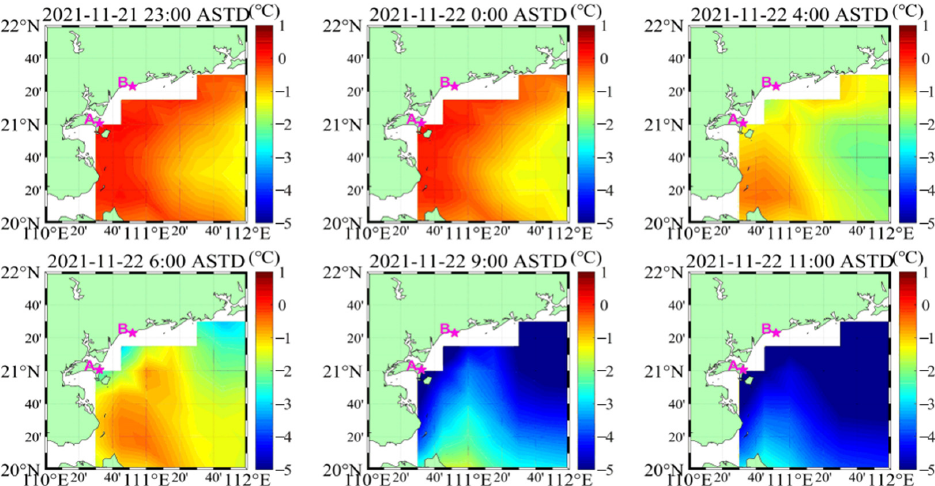
Figure 14. Spatial distribution of ASTD in the study area at the six typical times.